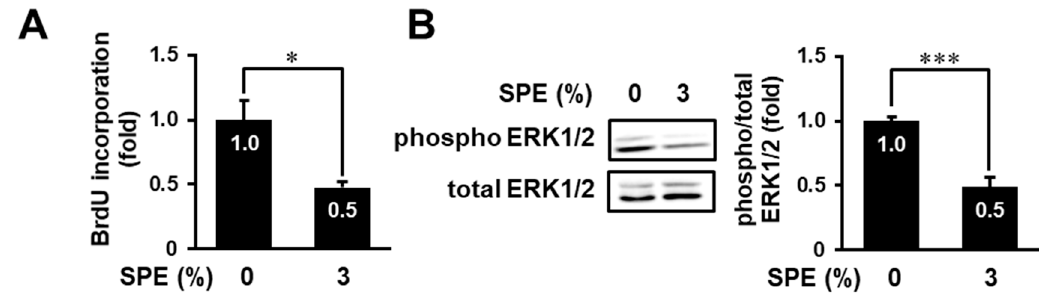
Figure 4. SPE inhibits cell proliferation and ERK1/2 in normal human epidermal keratinocytes (NHEKs). ( A ) NHEKs were treated with 3% SPE for 44 h and were subjected to the BrdU incorporation assay. ( B ) NHEKs were treated with 3% SPE for 1 h. Then, the cell lysates were prepared and immunoblotted with anti-ERK1/2 and anti-phospho-ERK1/2 antibodies. The levels of phosphorylated ERK1/2 were normalized to the levels of the total ERK1/2. The data are expressed as the mean ± SE derived from at least three independent experiments, and statistical analysis was performed by Student’s t -test; *** p < 0.001, * p < 0.05.